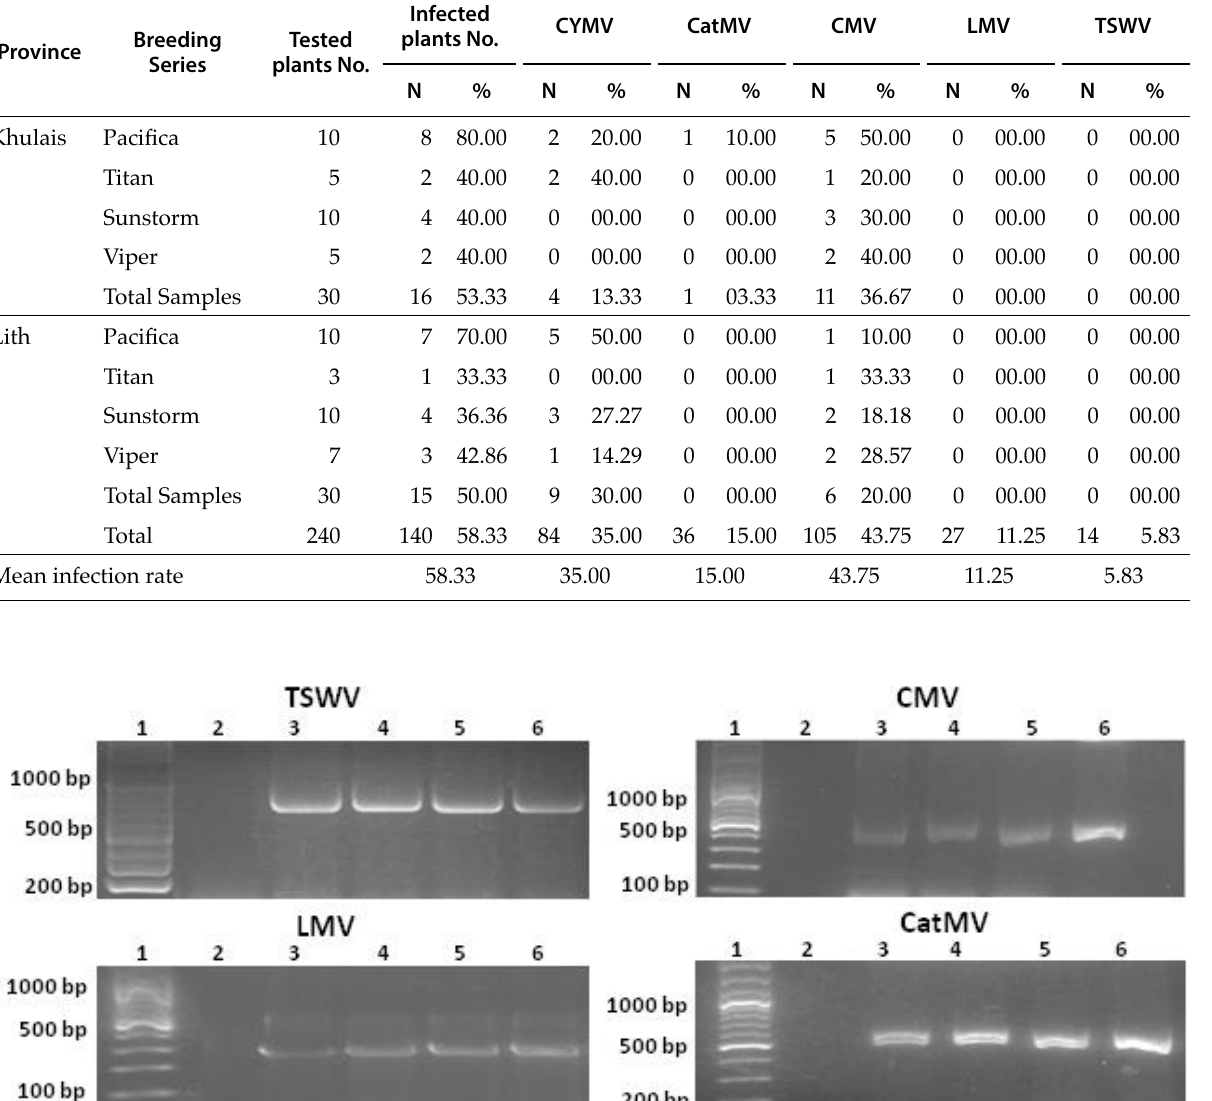
Figure 2. Electropherograms showing PCR and RT-PCR amplicons of different sizes (Table 1), obtained from periwinkle plants infected with TSWV, CMV, LMV, CatMV or CYMV. Lane 1: DNA ladder marker; lane 2: healthy periwinkle plants; lanes 3-6: infected periwinkle